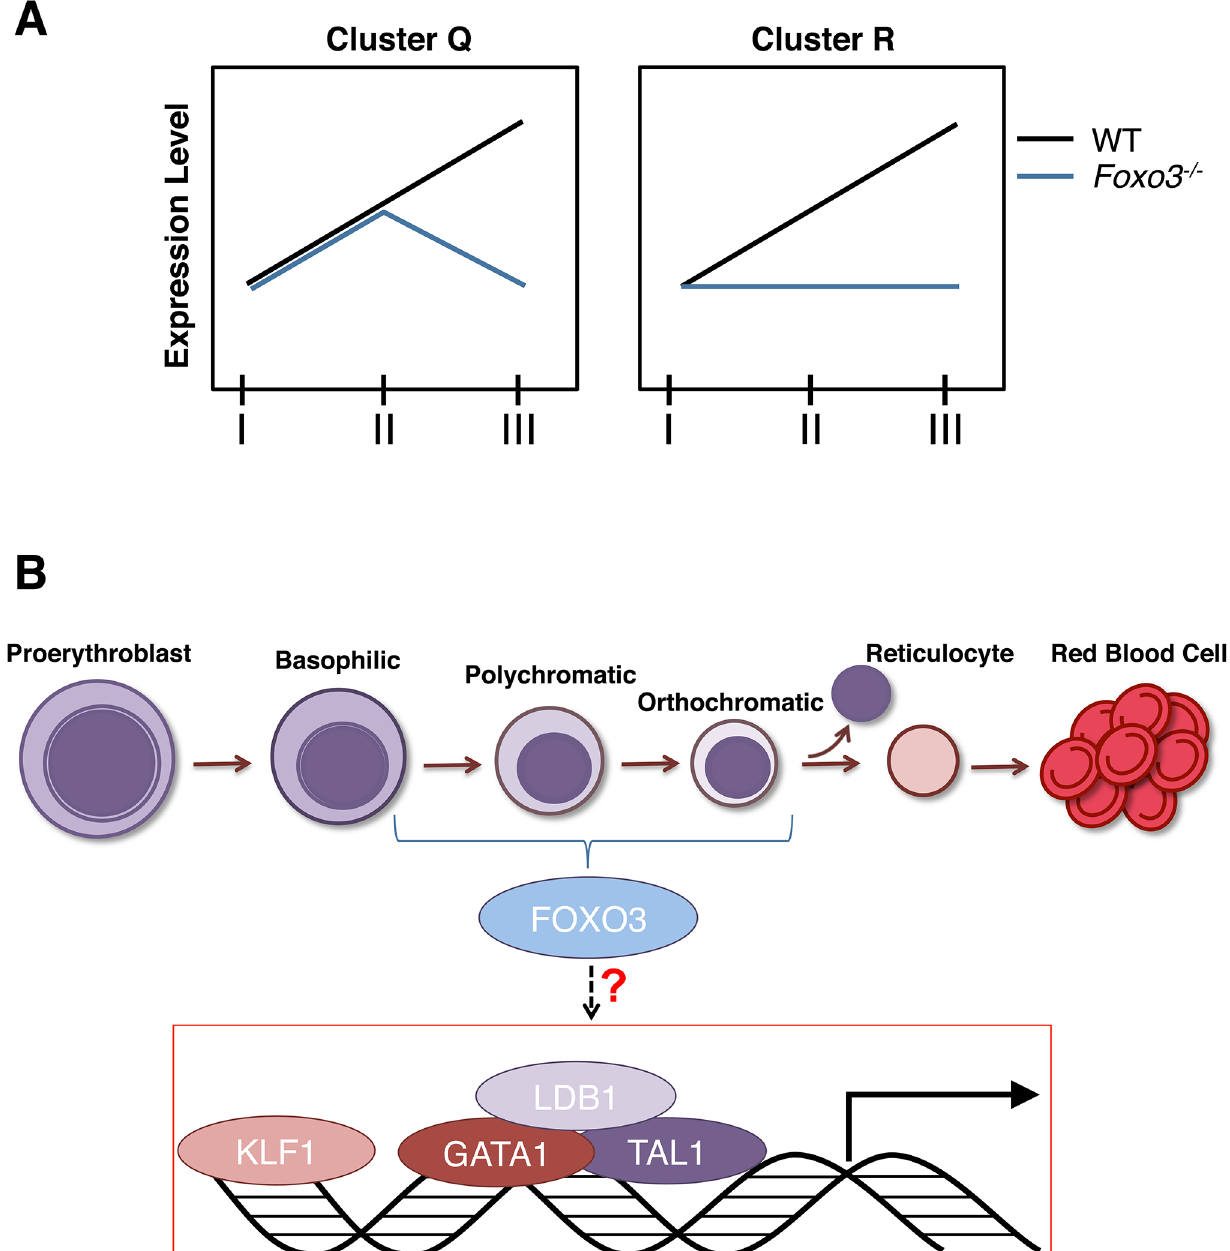
Fig 8. Model. (A) Depiction of expression of clusters Q and R genes in Foxo3 -/- versus wild type erythroblasts. Cluster Q is enriched for nucleosome assembly, heme biosynthesis, and DNA packaging-related processes while cluster R is enriched for autophagy and catabolic processes. (B) Model for gene expression in terminally maturing erythroblasts. Complexes of core erythroid transcription factors regulate the genetic programs required for maturation of the initial erythroblast stages. These transcription factor complexes may also induce Foxo3 expression in immature erythroblasts. In turn, FOXO3 cooperates with these factors to sustain and/or enhance the erythroid transcriptional program during the later stages of terminal